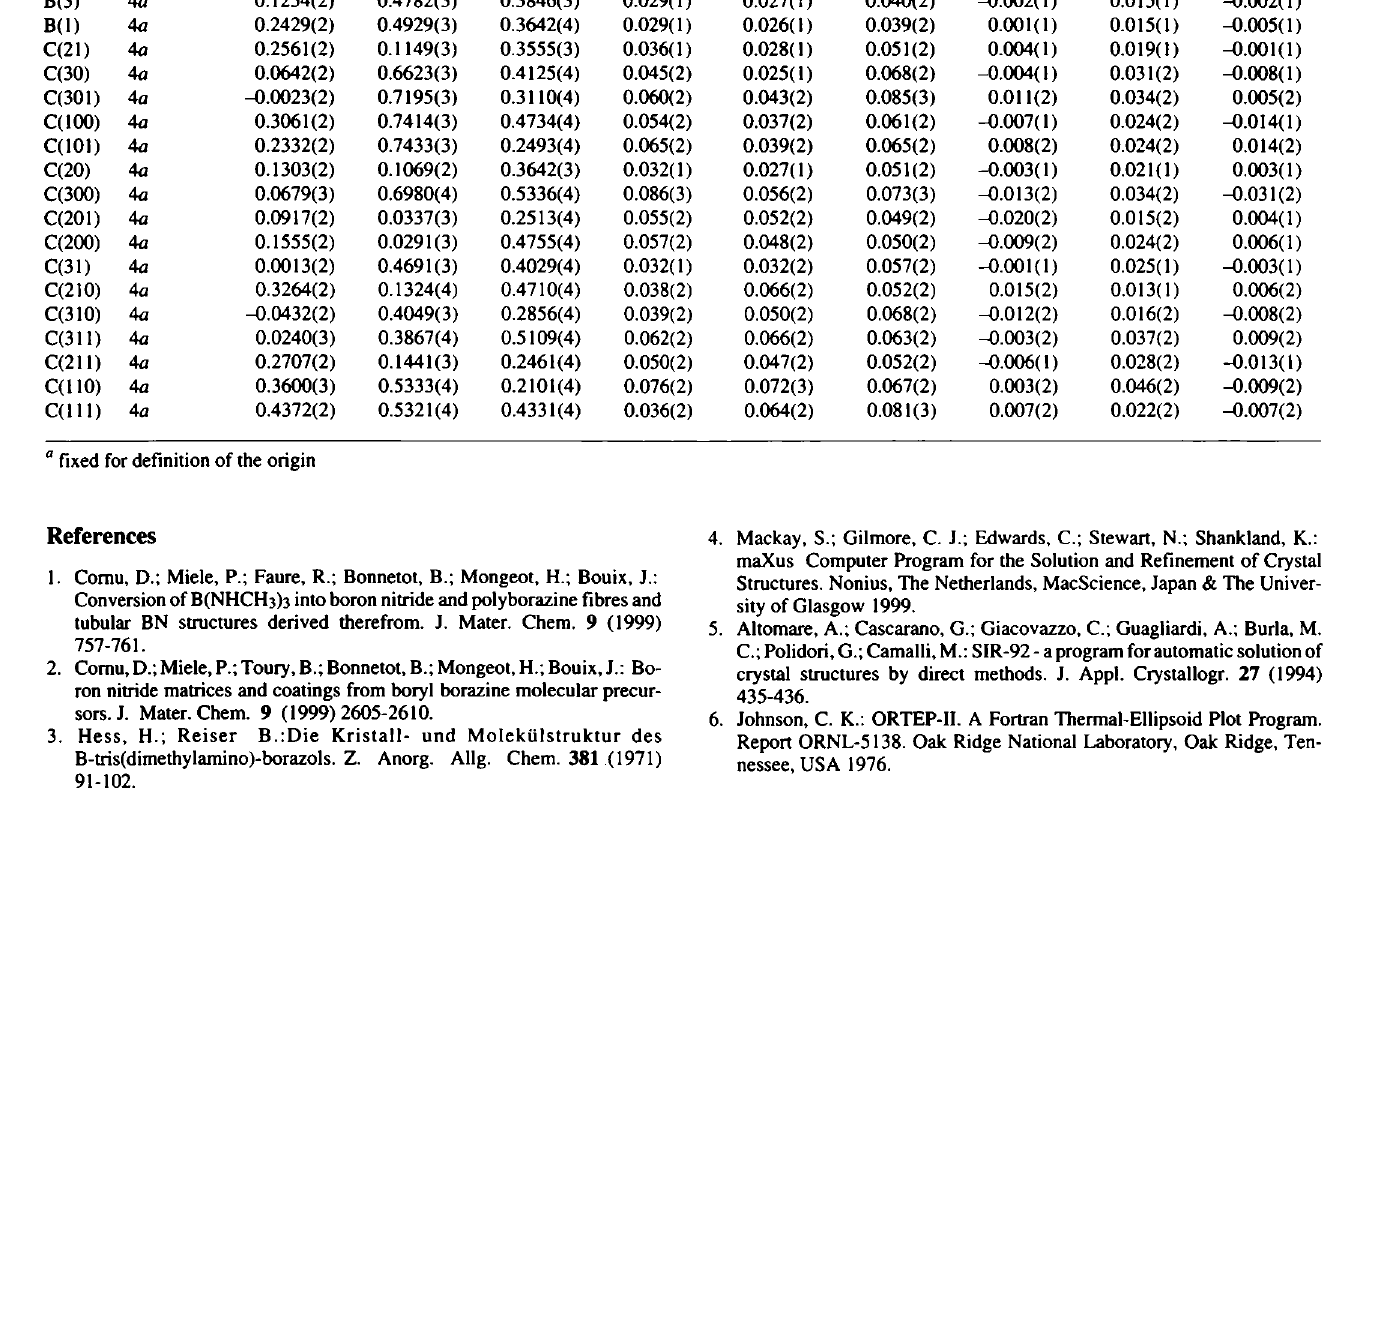
Table 3. Atomic coordinates and displacement parameters (in